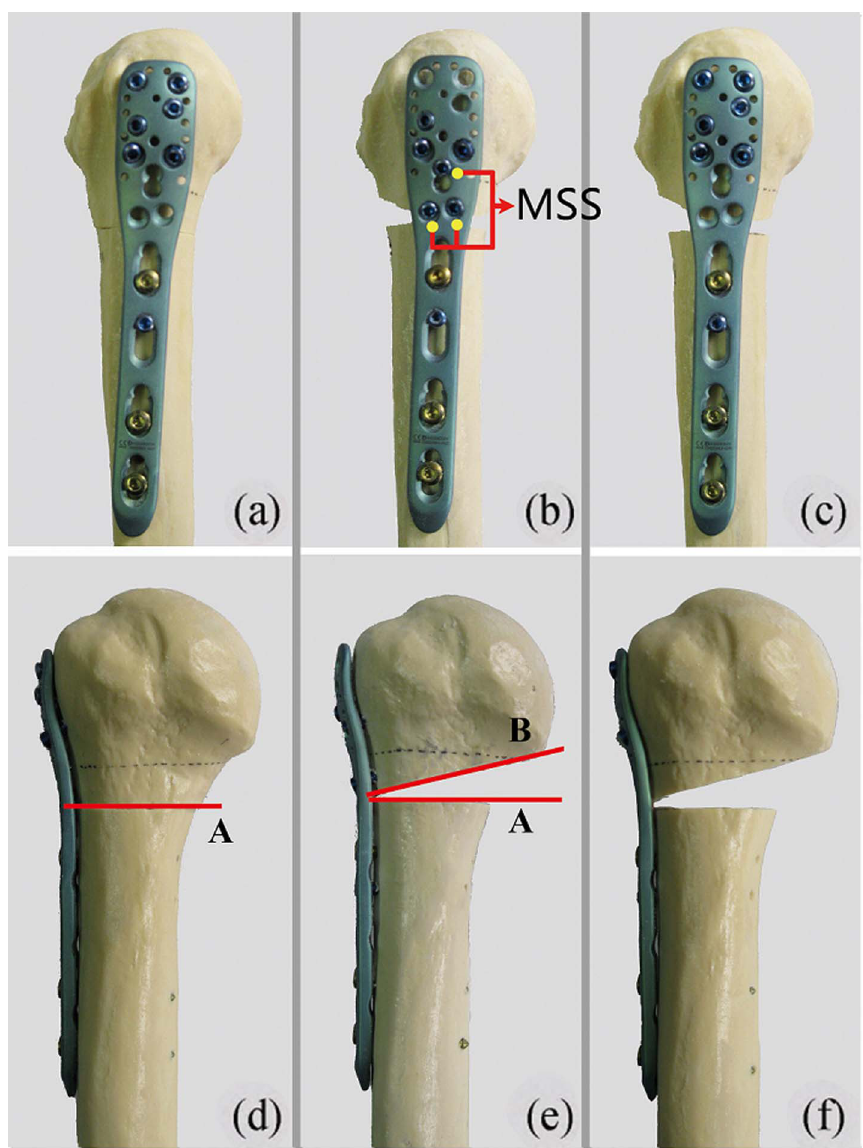
Figure 2. Division of the proximal humerus fracture models. In group A, proximal humerus fractures were fixed without MSSs (Fig.2a); transverse osteotomies were created along a horizontal line (line A) (Fig. 2d). In group B, proximal humerus fractures were fixed with 3MSSs(Fig.2b); wedge osteotomies were created along a horizontal line(line A) and an oblique line (line B) to simulate medial comminution of the proximal humerus(Fig. 2e). In group C, proximal humerus fractures were fixed without medial cortical support or MSSs(Fig.2c); wedge osteotomies were created identical to group B (Fig. 2f).